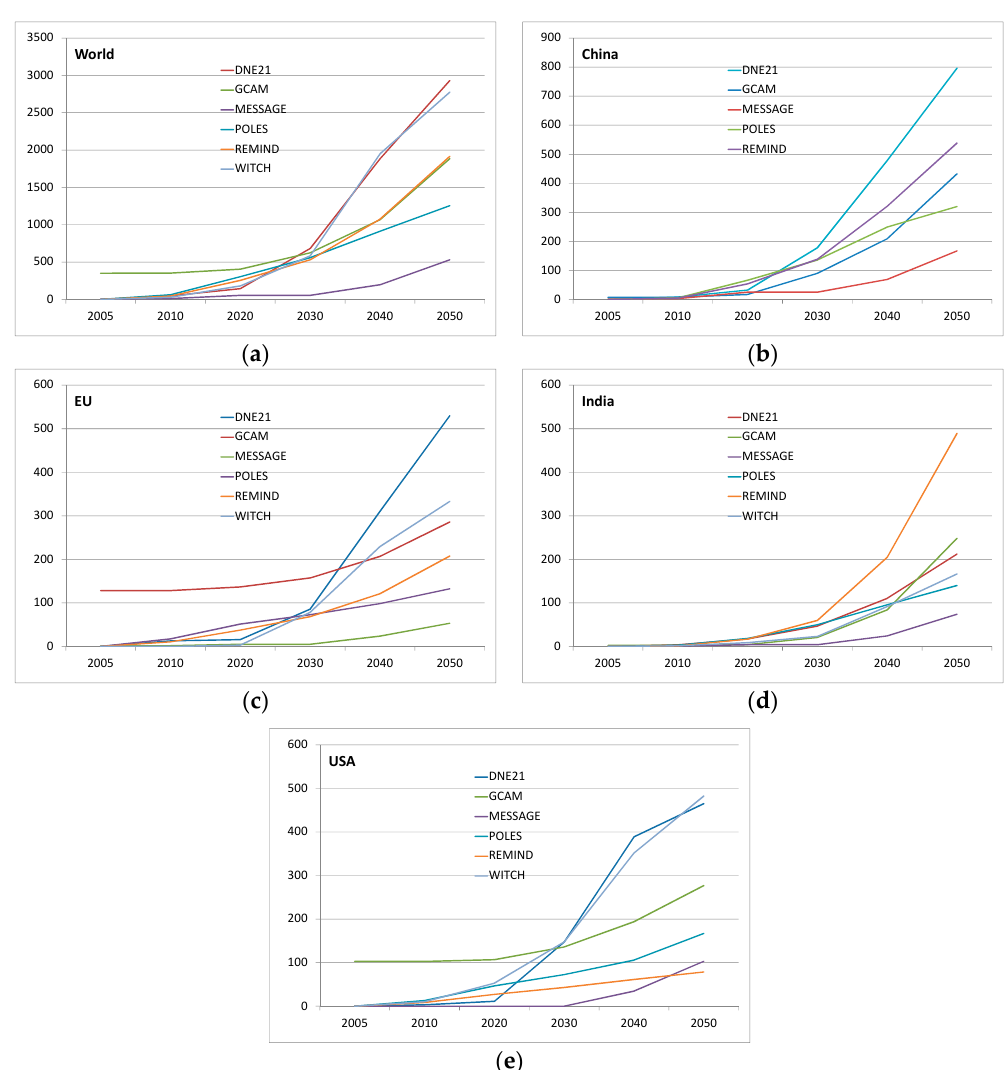
Figure B1. Inter-model comparison of installed capacity (GW) for nuclear in ( a ) World (2030–2050 growth rate = 4%–12% p.a.); ( b ) China (2030–2050 growth rate = 4%–12% p.a.); ( c ) The EU (2030–2050 growth rate = 3%–13% p.a.); ( d ) India (2030–2050 growth rate = 5%–13% p.a.) and ( e ) USA (2030–2050 growth rate = 3%–6% p.a.).